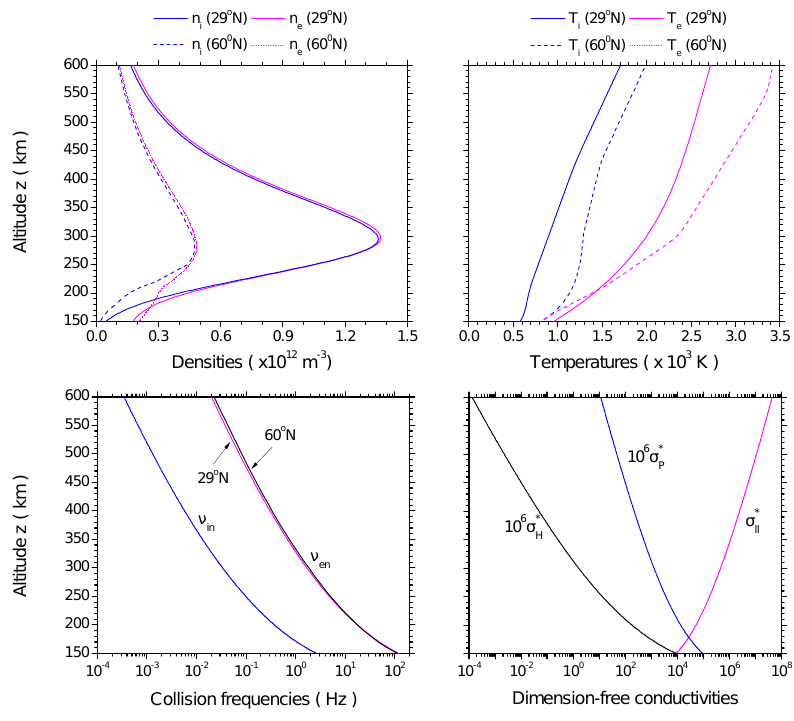
and n (upper left panel) and i e